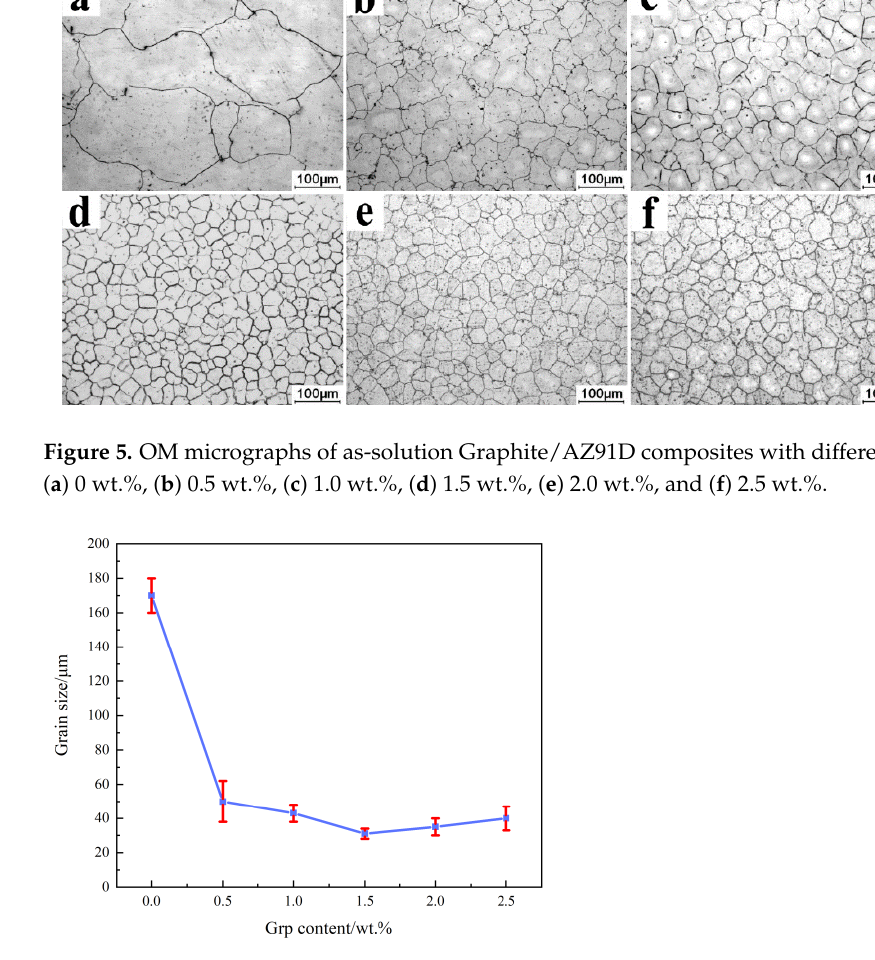
Figure 7. The dispersion of Grp with different Grp contents: ( a ) 0 wt.%, ( b ) 0.5 wt.%, ( c ) 1.0 wt.%, ( d ) 1.5 wt.%, ( e ) 2.0 wt.%, and ( f ) 2.5 wt.%. (Red arrows: the particles of Grp)